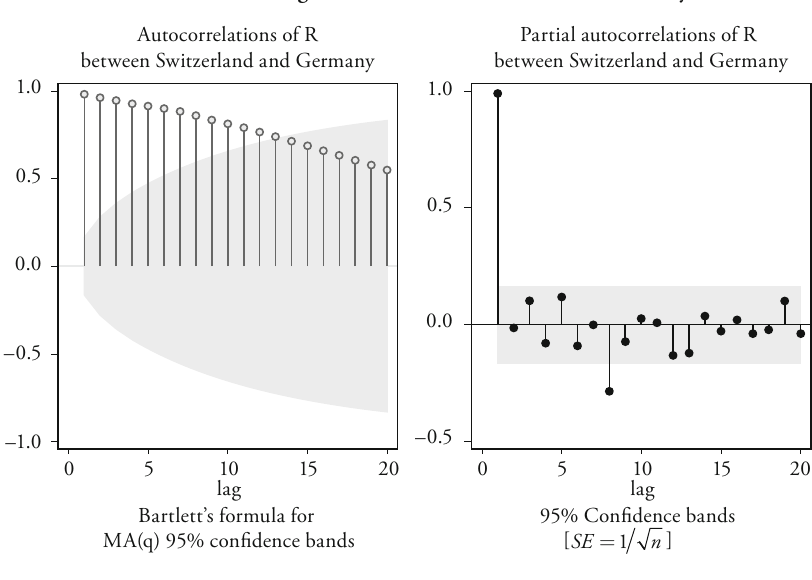
Figure : Autocorrelations and Partial Autocorrelations of the Real Exchange Rate between Switzerland and